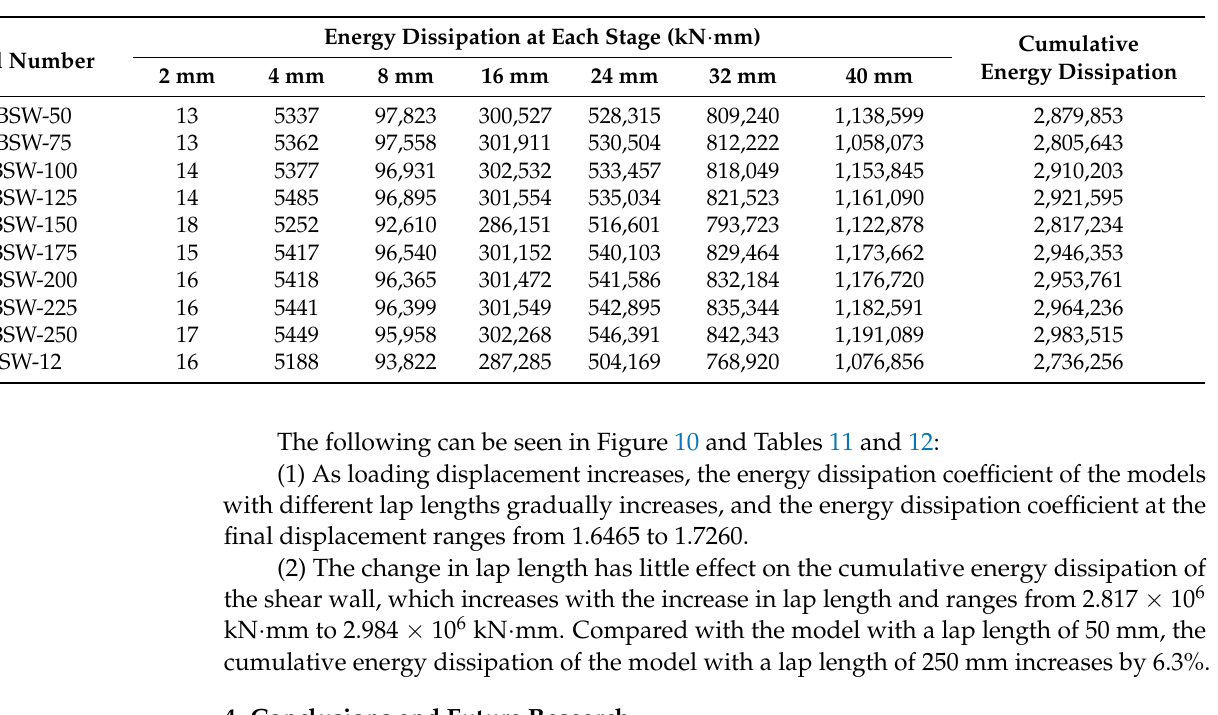
Table 12. Energy dissipation at all levels of models with different lap lengths.